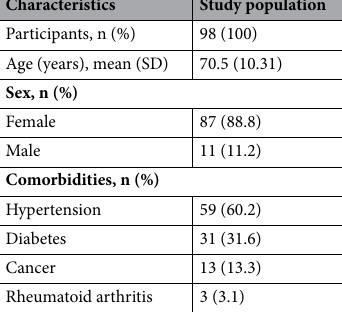
Table 1. Demographics and clinical characteristics. Values are n (%), mean (range), as indicated. The comorbidities has duplicate values.